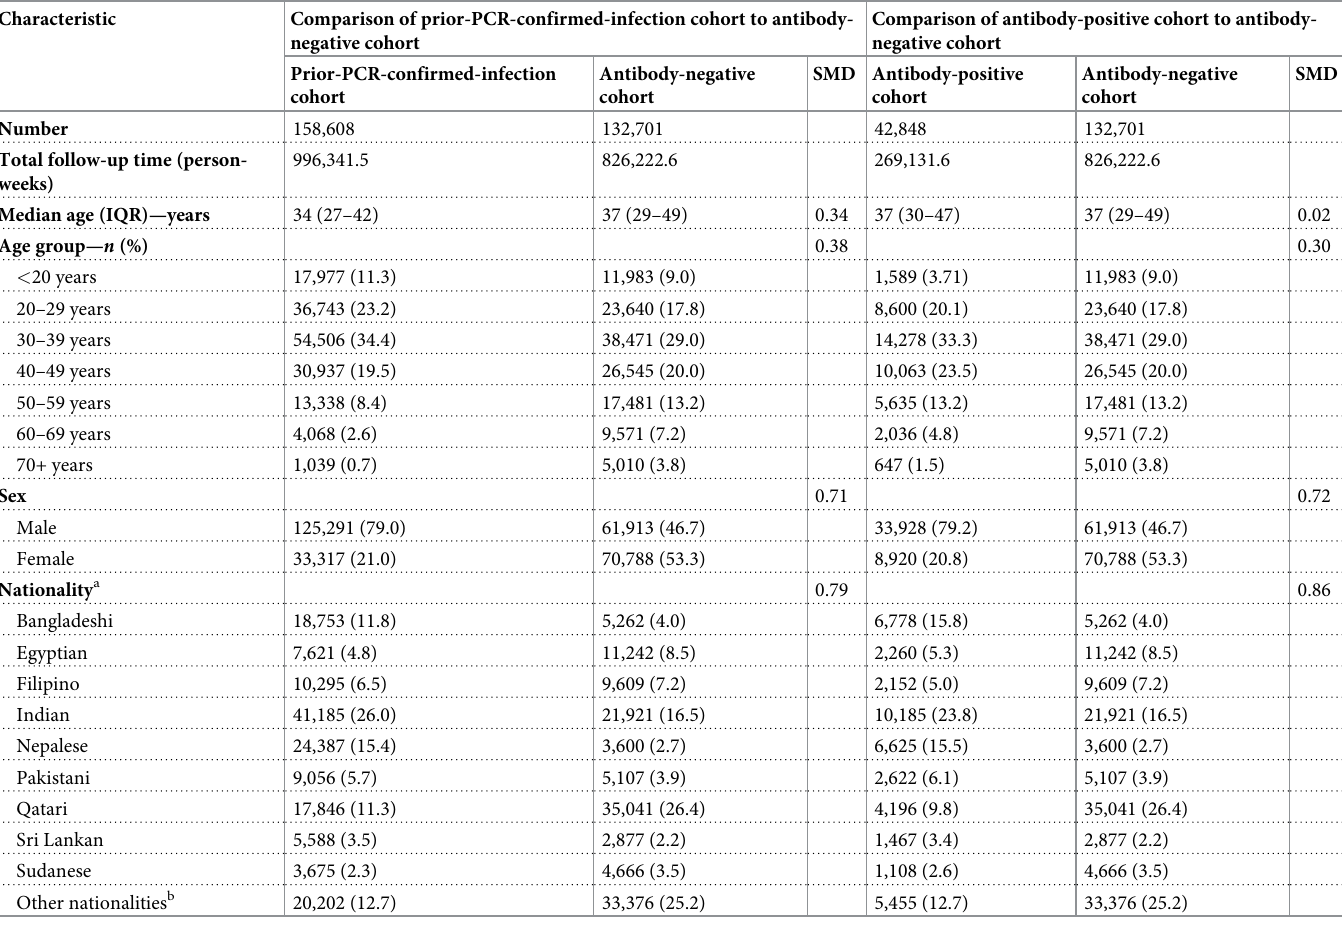
Table 2. Demographic characteristics of study